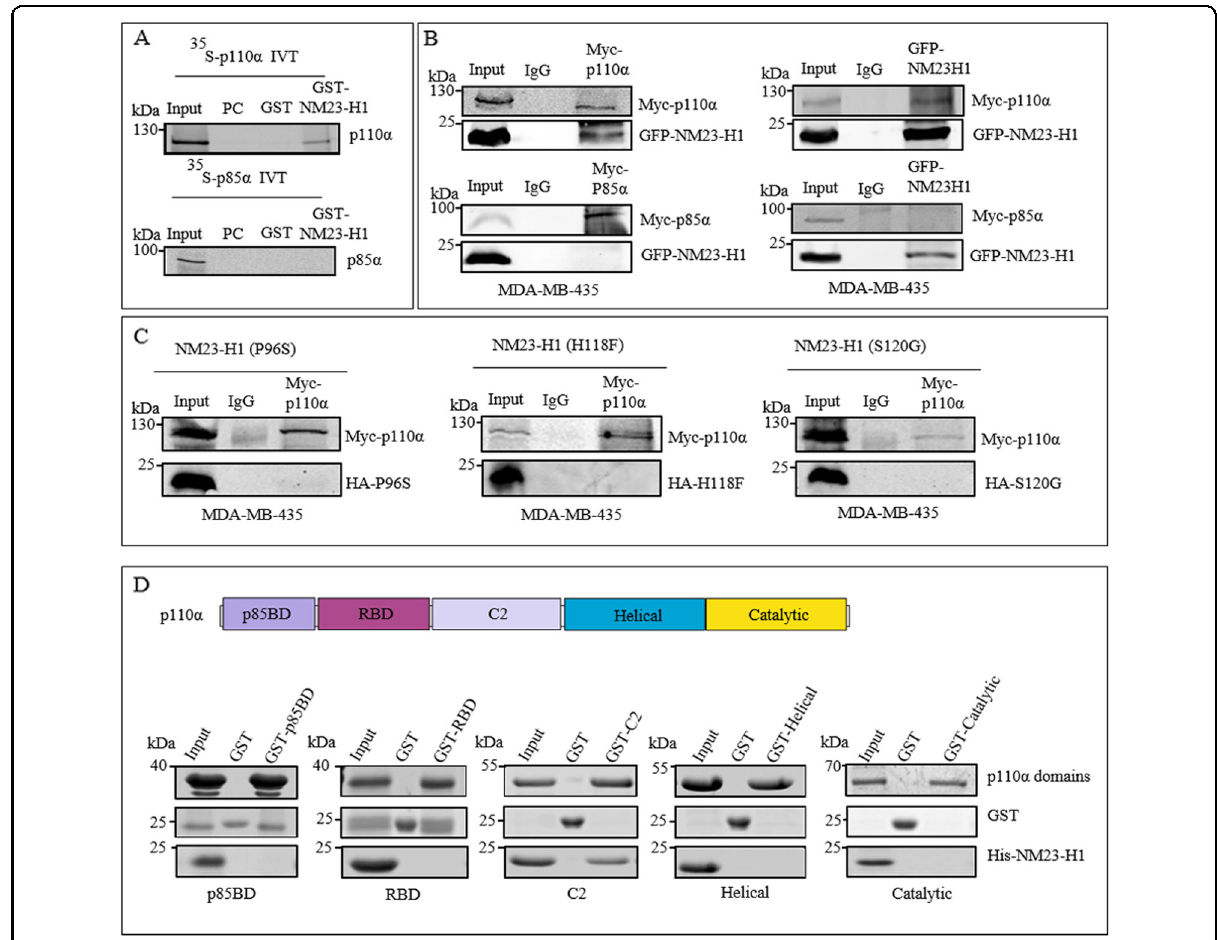
Fig. 1 The p110 α catalytic subunit of PI3K interacts with NM23 ‐ H1 in vitro and forms a protein-protein complex in cells. A [ 35 S] methionine ‐ labeled in vitro translated p110 α and p85 α were incubated with either GST or GST ‐ NM23 ‐ H1 fusion protein. Bound proteins were resolved on SDS ‐ PAGE and analyzed using Image Quant software. Lane 1, 5% input labeled lysate; lane 2 pre-clear, lane 3 pull-downs with GST; lane 4, pull-down with GST ‐ NM23 ‐ H1 fusion protein. B Cell lysates from MDA-MB-435 cells transfected with Myc-p110 α (upper panel) or p85 α (bottom panel) plasmids were incubated for Co-IP with either IgG, Anti-Myc antibody or Anti-GFP antibody. Bound proteins were resolved on SDS ‐ PAGE and membranes were analyzed by the Odyssey imaging system. Lane 1, 5% MDA-MB435 cell lysates; lane 2, Co-IP with Mouse IgG; lane 3, Co-IP with Myc fusion protein (left panel) or GFP fusion protein (right panel). C Cell lysates from MDA-MB-435 transfected with Myc-p110 α and HA-P96S, HA-H118F or HA-S120G NM23- H1 mutant proteins were resolved on SDS ‐ PAGE and membranes were analyzed by the LI-COR Odyssey imaging system. Lane 1, 5%